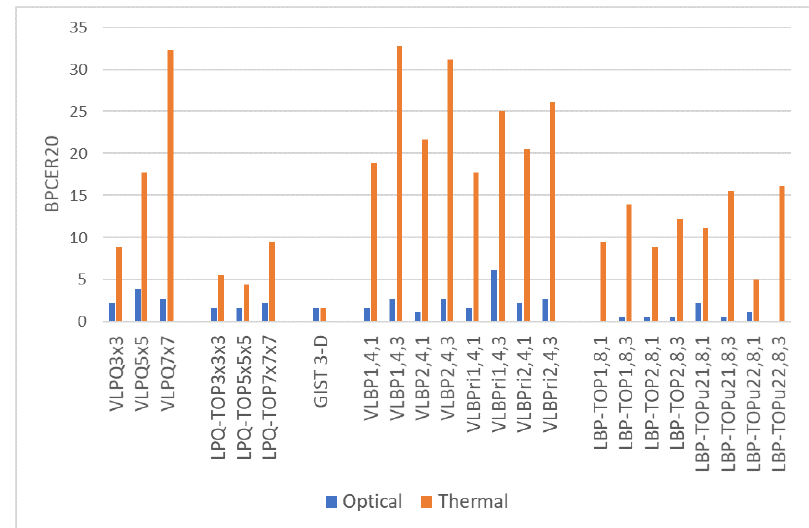
Figure 12. PAD accuracy for the two sensors in terms of